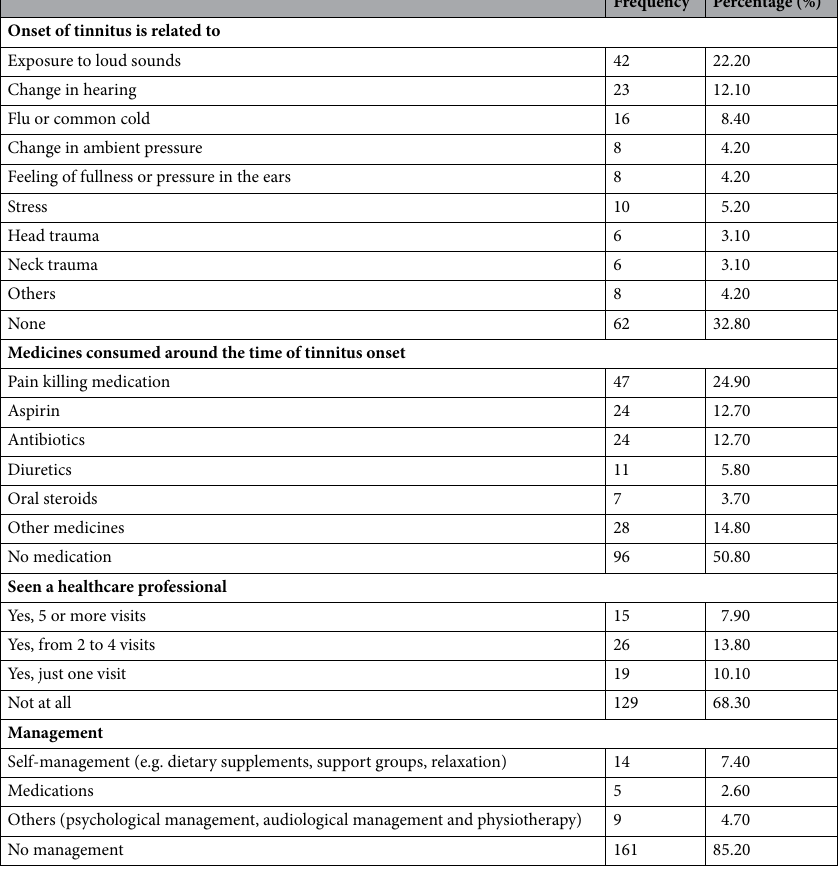
Table 4. Characteristics of Tinnitus onset and management options among study participants (n =